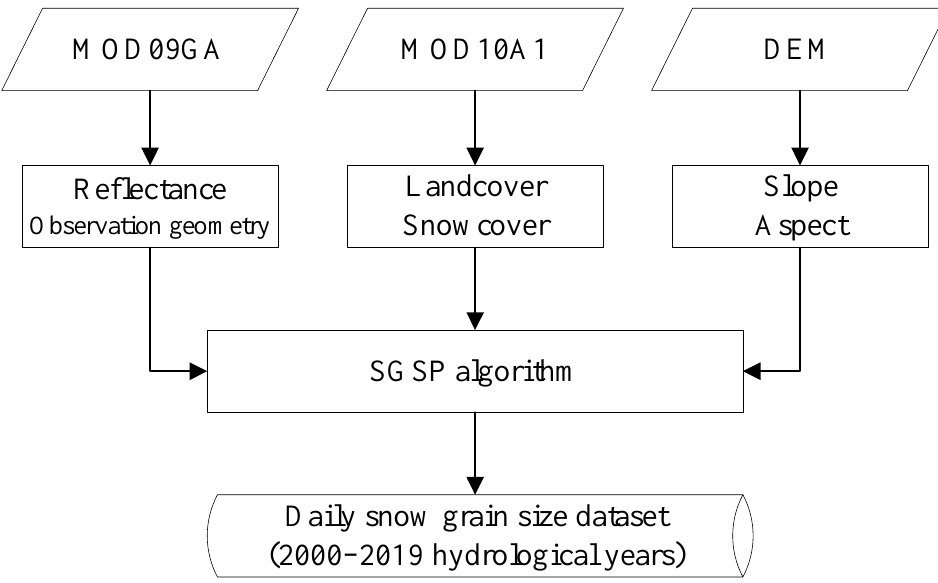
Figure 5. Flowchart for estimating snow grain size.